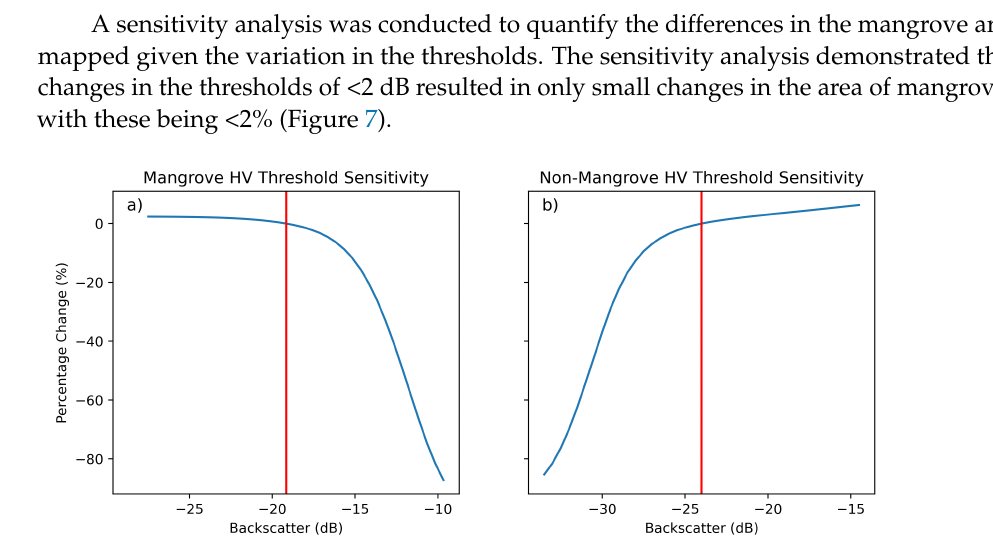
Figure 7. Sensitivity of the mangrove ( a ) and non-mangrove ( b ) change thresholds. These plots illustrate the percentage of change in the number of mangrove or non-mangrove pixels classified with the change in threshold, where the red line indicates the threshold